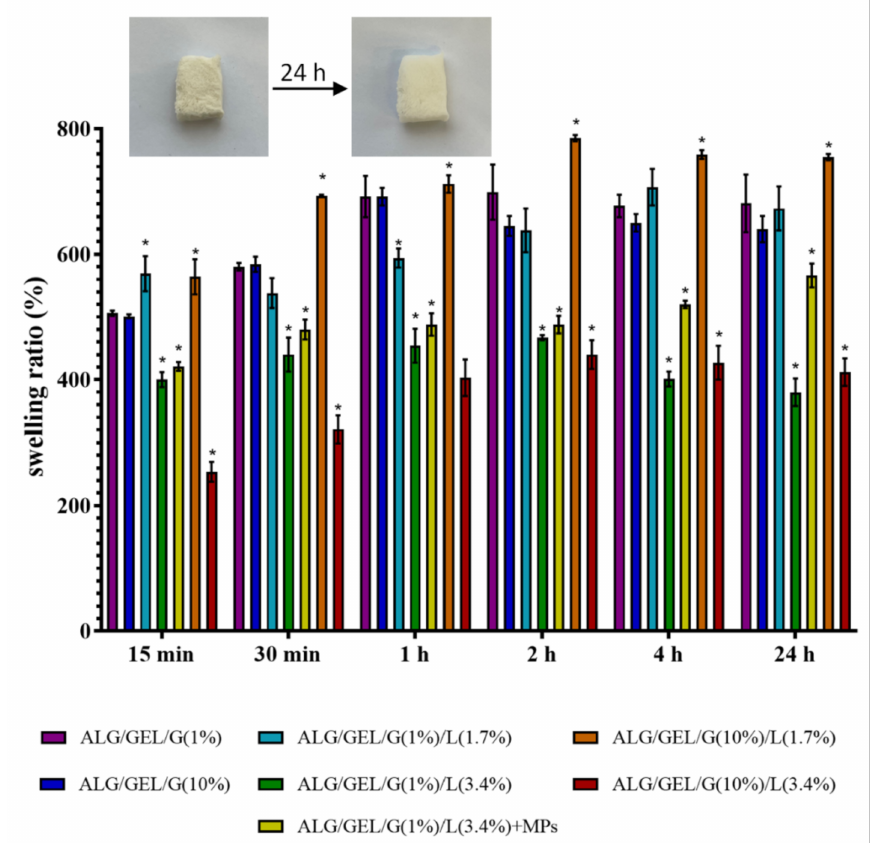
Figure 6. The swelling percentage of cross-linked lyophilized emulsions based on sodium alginate and gelatin with different amounts of glycerol compared to the control samples (without lipids). The pictures present an exemplary sample (cross-linked ALG/GEL/G(1%)/L(3.4%)) before and after 24 h of incubation in PBS buffer. ANOVA-one way with Dunnett’s post-hoc analysis (Cl = 95%) was performed to statistically compare the results. Significant differences compared to the control for each time were marked on the graph with